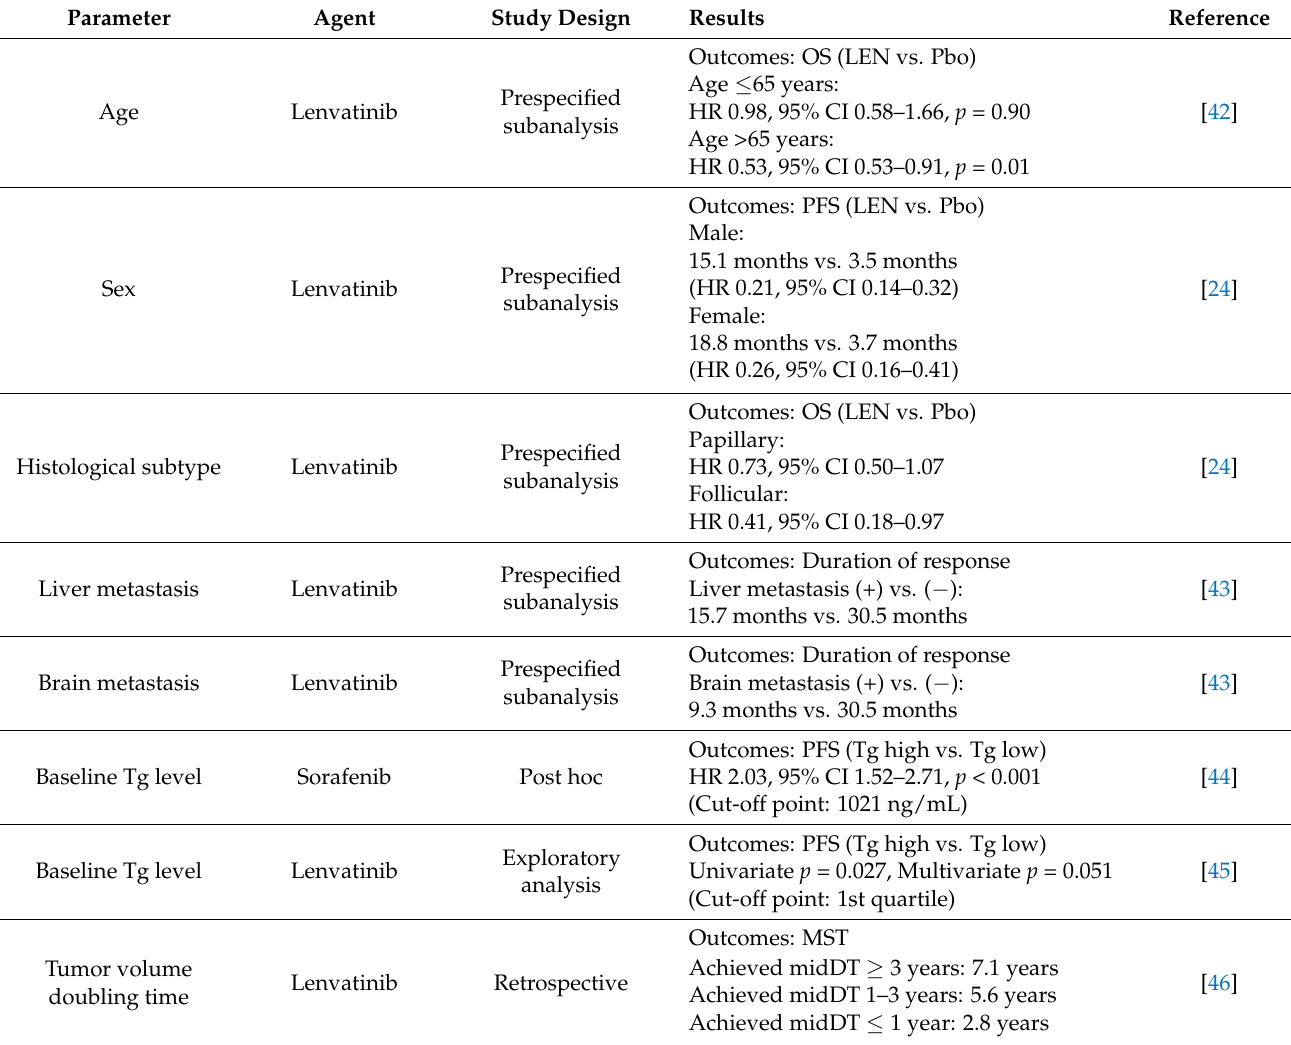
Table 2. Summary of reported clinical factors that affect outcomes of MKIs in patients with RR-DTC. Parameter Agent Study Design Results